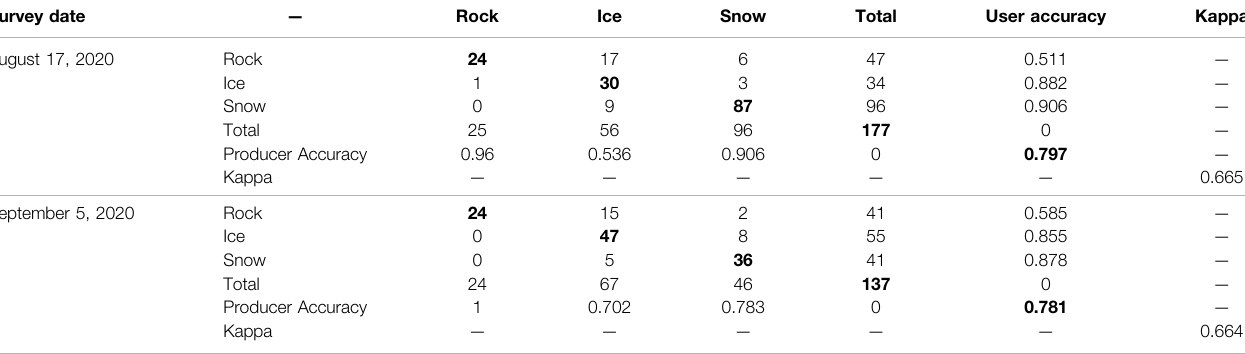
The bold values represent the number of points that were correctly classi fi ed for each information class.